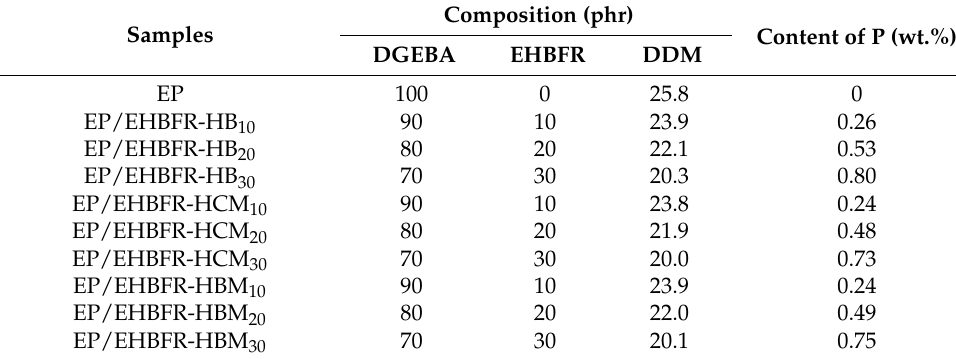
Table 1. Formulations of different